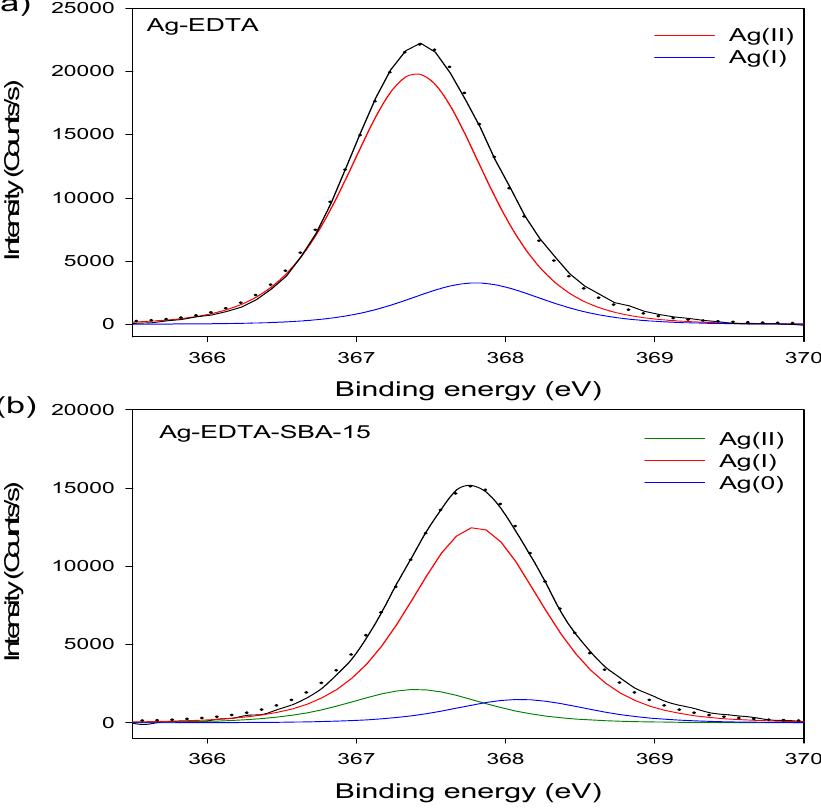
Figure 3. XPS Ag3d spectrum for high valence Ag samples: ( a ) Ag-EDTA and ( b ) Ag-EDTA-SBA-15.